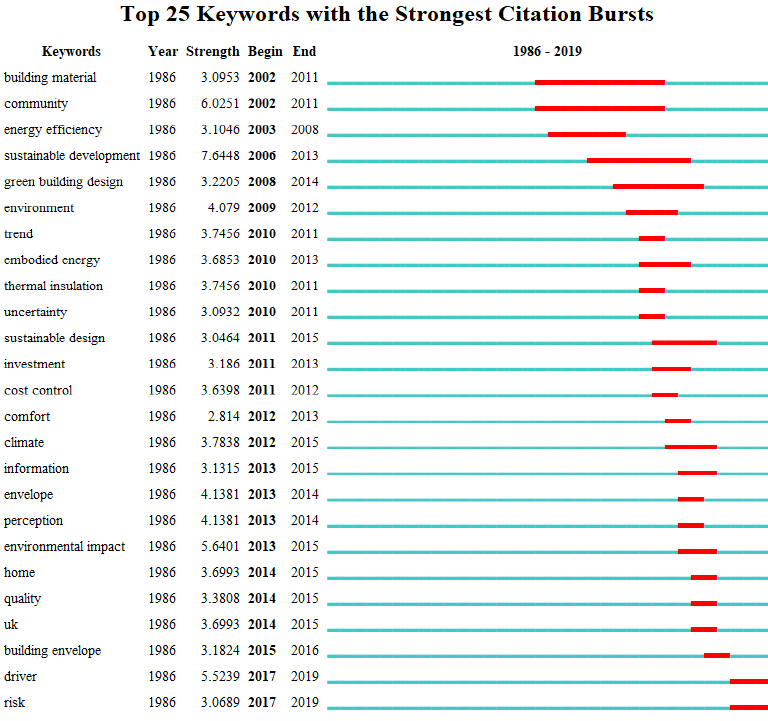
Figure 4. Top 25 keywords with strongest citation burst.